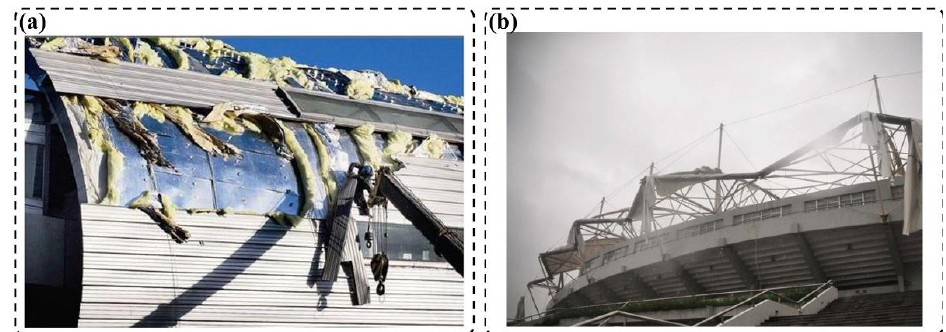
Figure 1. Example of wind damage to large-span roof structures: ( a ) Beijing Capital Airport T3 cover was lifted; ( b ) Zhejiang Jiaxing Pinghu gymnasium cover was torn.